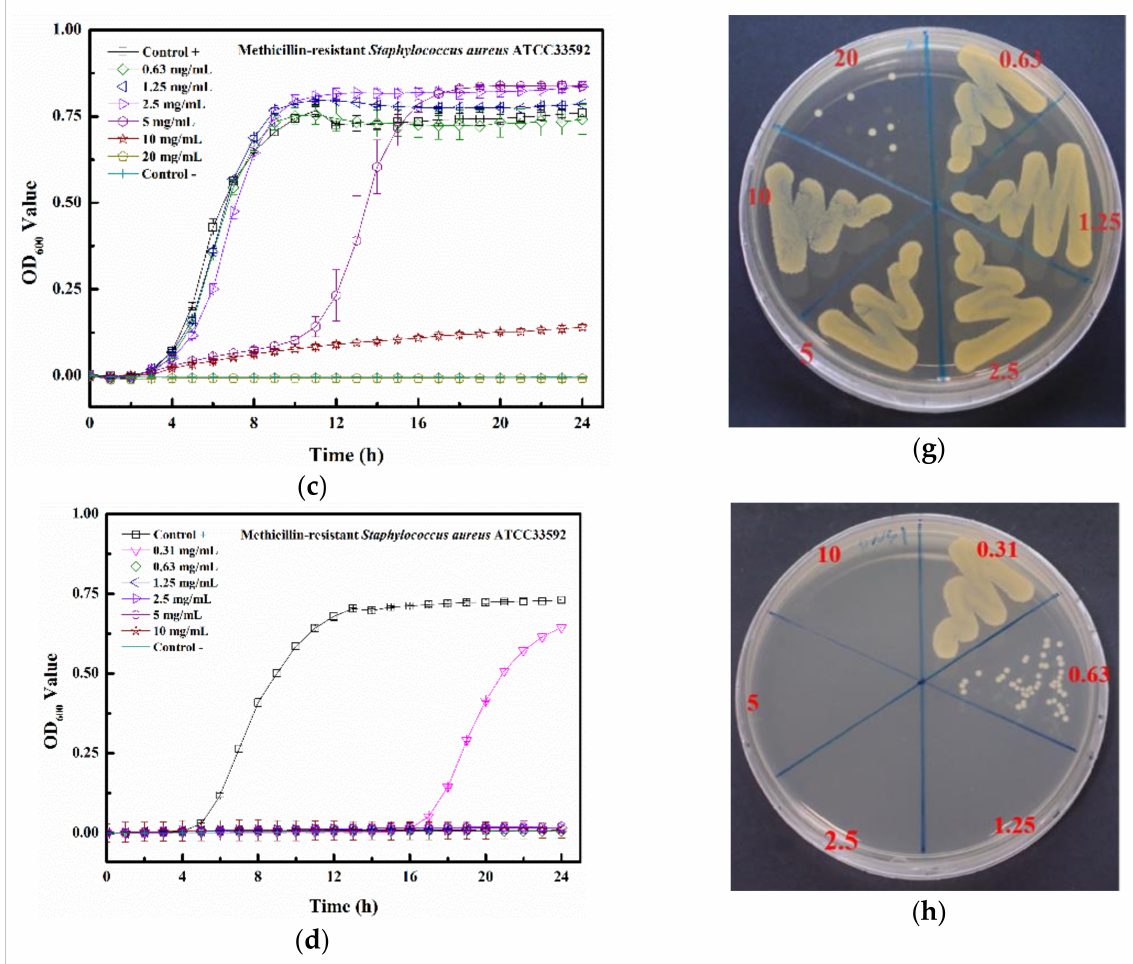
Figure 7. Growth curve results for ( a ) W-Ag, ( b ) PBS-Ag, ( c ) TSB-Ag, and ( d ) Tau-Ag. The results are represented as the absorbance at 600 nm, with dots as means and bars as SD. Colony-forming tests results for ( e ) W-Ag, ( f ) PBS-Ag, ( g ) TSB-Ag, and ( h )